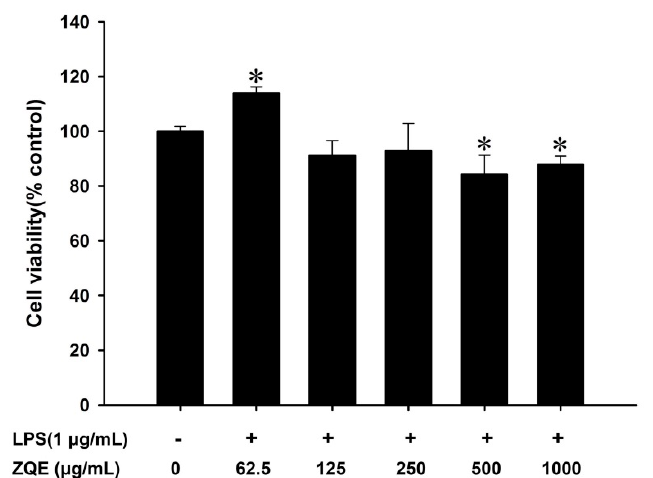
Figure 3. Effects of ZQE on cell viability in RAW 264.7 macrophages. The cells were treated with ZQE (0, 62.5, 125, 250, 500, and 1000 µ g/mL) in the presence of LPS (1 µ g/mL) for 18 h. Cell viability was measured by a MTT assay. The data shown are from three independent experiments expressed as mean ± SD. * p < 0.05 compared to the control (without ZQE and LPS). LPS: lipopolysaccharide; MTT: Methylthiazolyldiphenyl-tetrazolium bromide.